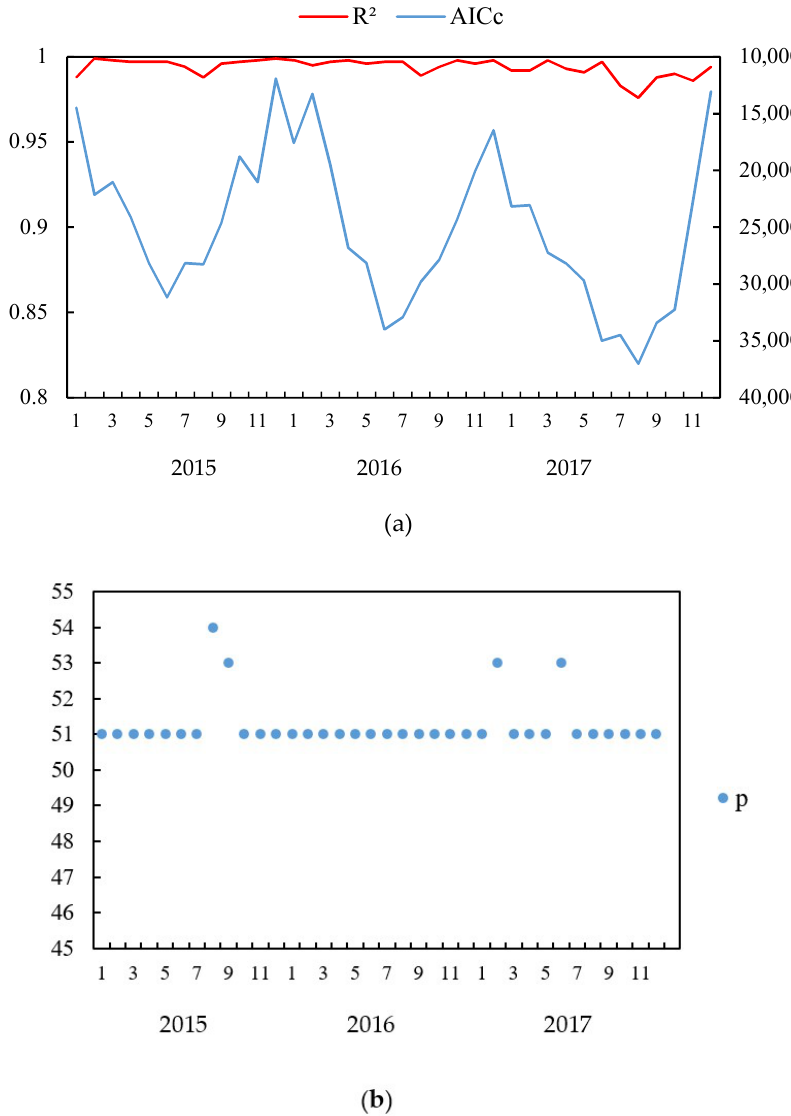
Figure 4. R 2 , AICc ( a ), and p -values ( b ) of GWR models for each month.